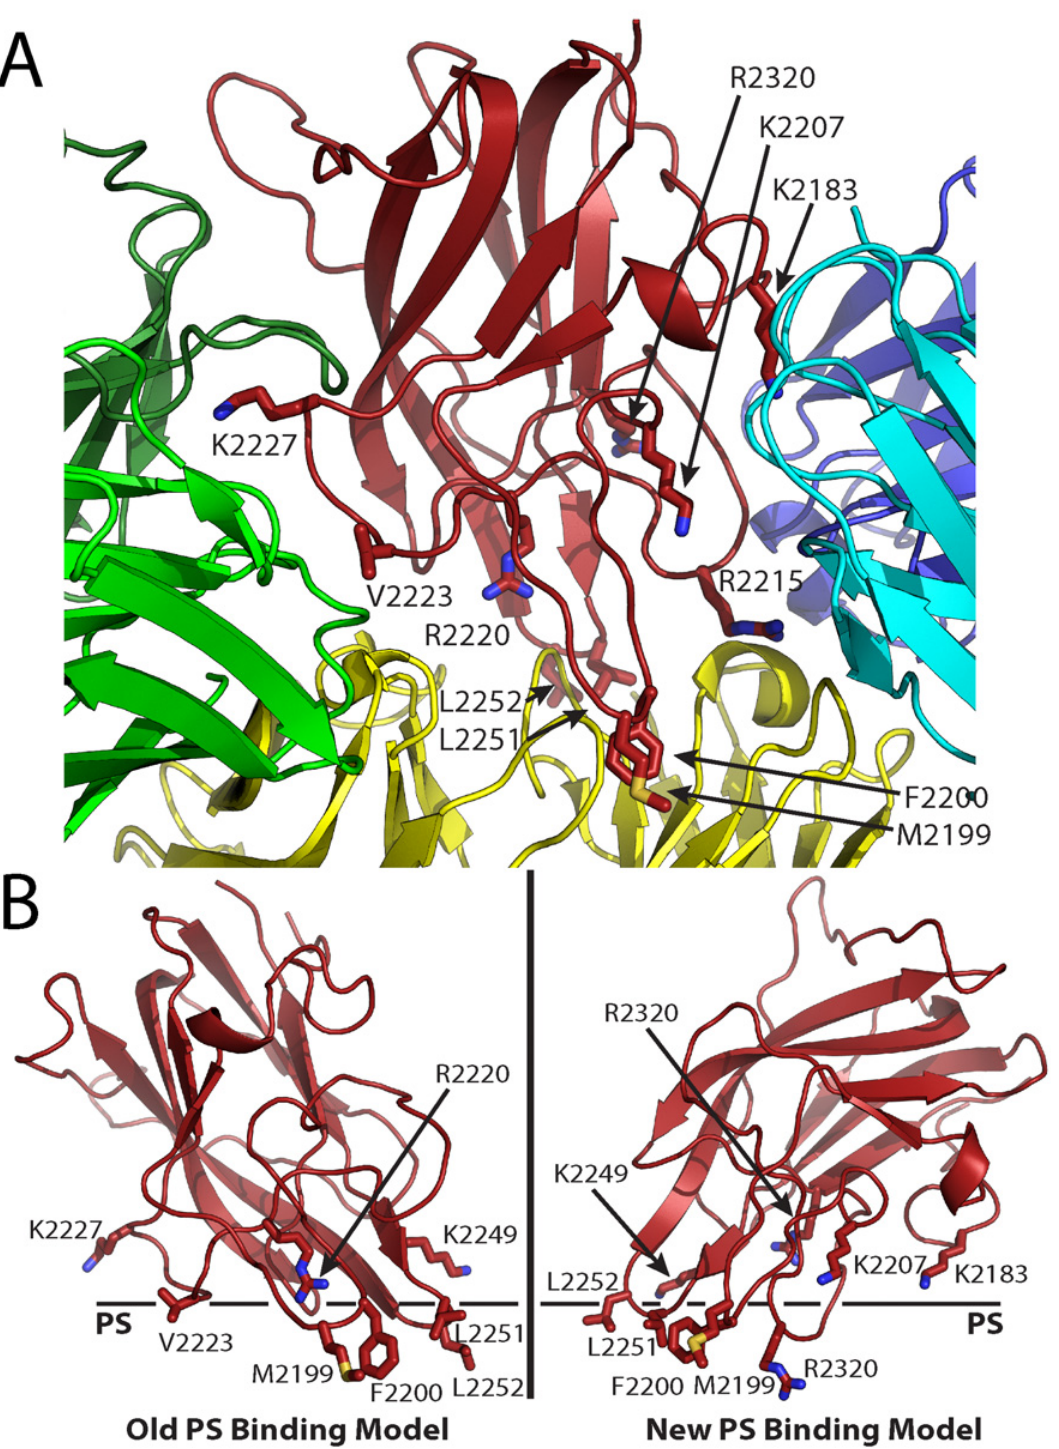
Fig 1. Factor VIII C2 domain-specific inhibitory antibody epitopes and membrane binding models. (A) Ribbon diagram representation of the fVIII C2 domain bound to different classes of C2-specific inhibitory antibodies. Each X-ray crystal structure was superimposed with the C2 domain structure and residues involved in the different epitopes are shown by stick representation (red: fVIII C2 domain; green: G99 mAb, a non-classical BC epitope; blue/cyan: 3E6 mAb, a classical A epitope; yellow: BO2C11 mAb, a classical AB epitope). (B) Proposed PS membrane binding models for the fVIII C2 domain (left: old PS binding model, including the non-classical epitope with residues K2227 and V2223; right: new PS binding model, including both 3E6 and BO2C11 classical antibody epitopes, which centers at residue R2320).